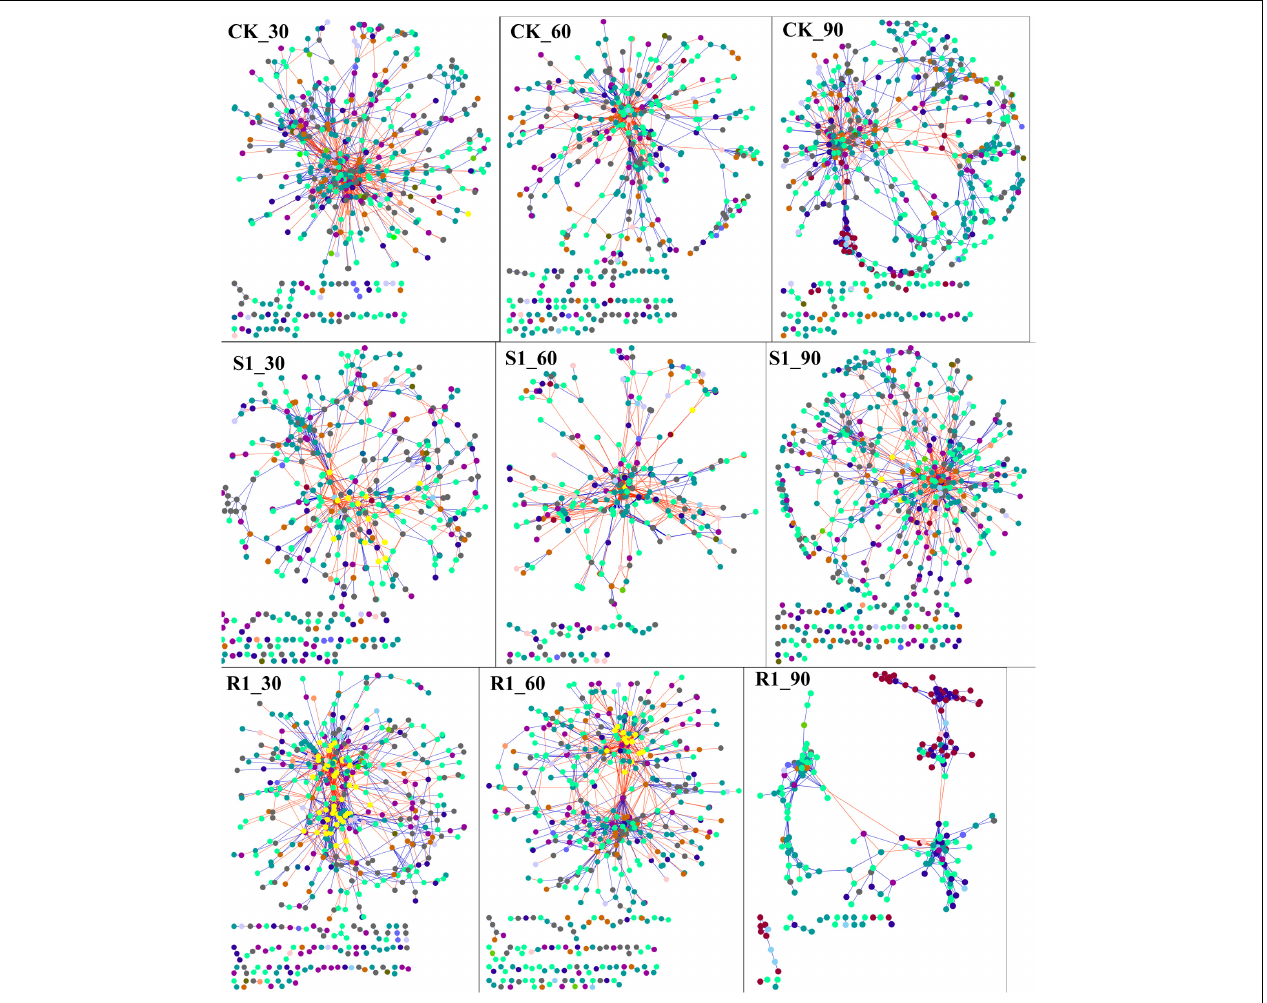
FIGURE 4 | Shifts of molecular ecological networks in CK, S1, and R1 groups. The red line represented the negative correlation, and the blue line represented the positive correlation. The color of the circle represented the phylum of the node. CK, control group ( N = 8); R1, treatment with functional microflora R1 ( N = 8); S1, treatment with functional microflora S1 ( N =